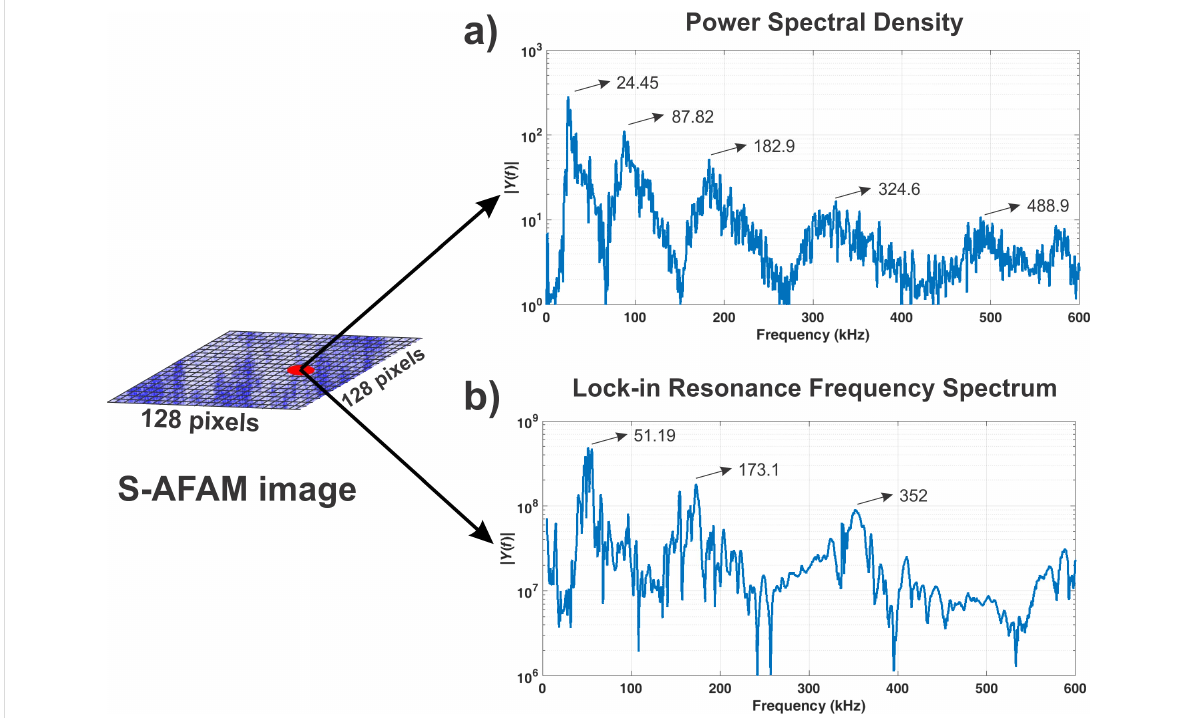
Figure 2: Contact resonance frequencies for a graphite film on a glass substrate. a) Resonance flexural modes acquired using S-AFAM, b) reso- nance flexural modes acquired using a lock-in amplifier.